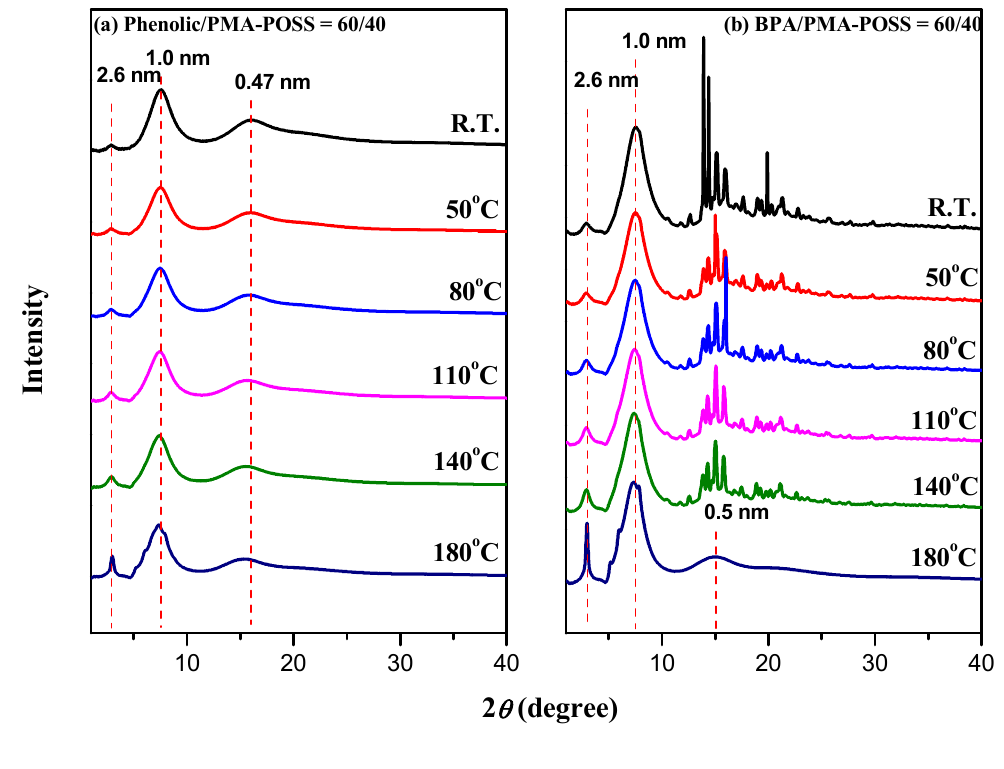
Figure 14. WAXD patterns of ( a ) phenolic/PMA-POSS = 60/40 and ( b ) BPA/PMA-POSS = 60/40 blends, recorded at various